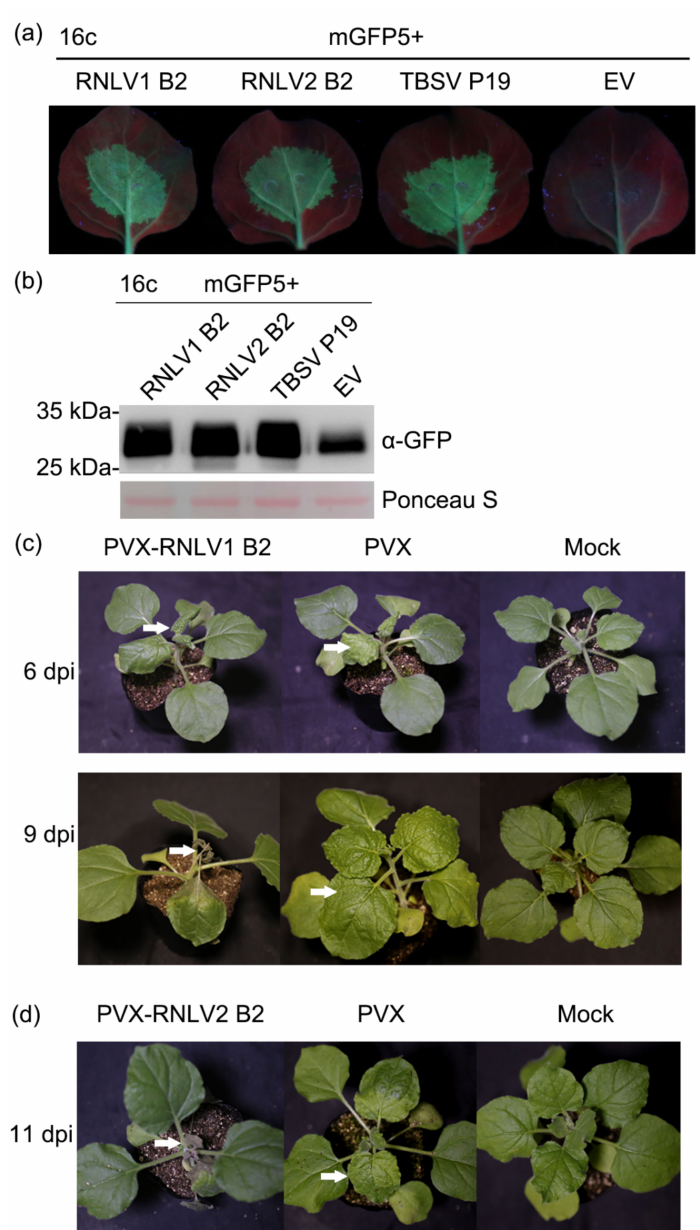
Figure 4. Both RNLV1 and RNLV2 B2 proteins can suppress RNA silencing in plants. ( a ) Images of transgenic 16c N. benthamiana leaves co-expressing mGFP5 and RNLV1 B2, mGFP5, and RNLV2 B2, mGFP5 and TBSV P19 (the positive control), or mGFP5 and the empty vector (EV, the negative control). These leaves were examined and photographed under a UV light at 5 dpi. Weak green fluorescence in the leaf tissues co-expressing mGFP5 and EV indicated the silencing of mGFP5 expression. ( b ) Western blot analysis of mGFP5 accumulation in the infiltrated leaf tissues at 5 dpi. The Ponceau S-stained large RuBisCO subunit gel is used to show sample loadings. ( c ) Images of PVX-RNLV1 B2-, PVX-, and mock-inoculated N. benthamiana plants at 6 and 9 dpi. White arrows indicate the leaves showing disease symptoms. ( d ) By 11 dpi, the PVX-RNLV2 B2-inoculated plants also developed necrosis in their systemic leaves, but not the PVX-inoculated or the mock-inoculated N. benthamiana plants. White arrows indicate the leaves showing disease